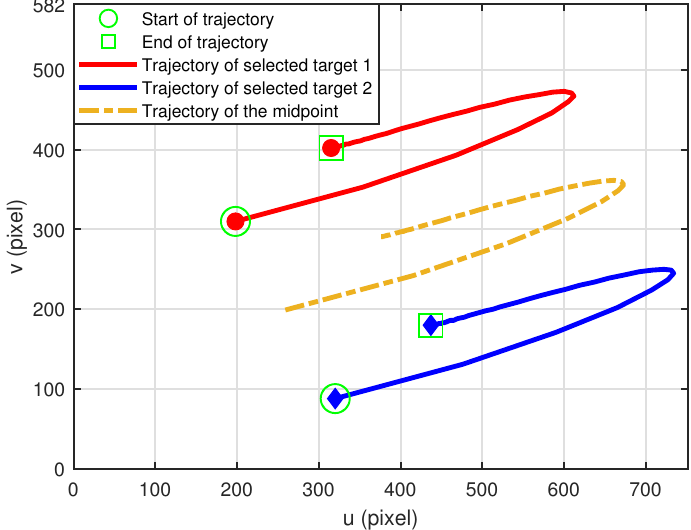
Figure 7. The trajectories of the two selected targets and their midpoint.